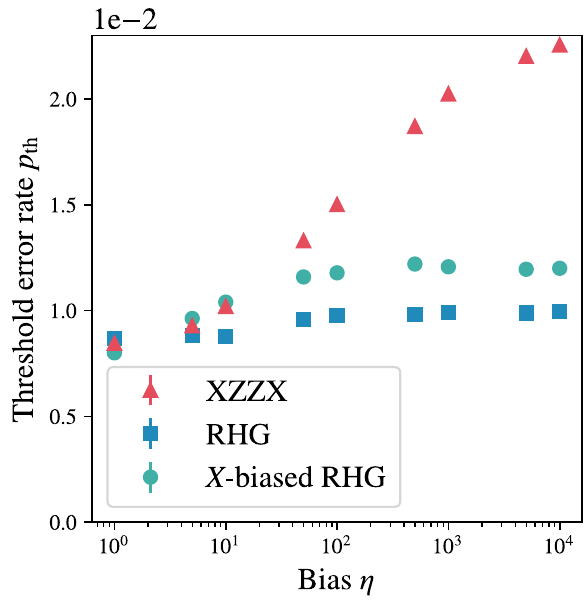
Fig. 4 The threshold error rate p th as a function of bias η for the three cluster states we consider, the XZZX and RHG cluster states with Z -biased noise and the RHG cluster state with X -biased noise. Here p th refers to the total error rate of the CZ gate in the corresponding noise model. We see that the XZZX cluster state strongly outperforms both RHG cluster states, although the RHG cluster state has a modestly improved threshold for X -biased noise as compared to Z -biased. The error bars (standard deviation) are smaller than the marker size in the fi